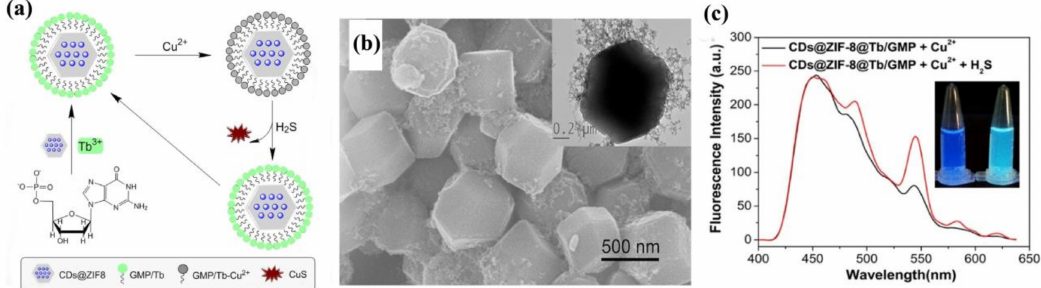
Figure 10. ( a ) Schematic illustration of the preparation of CDs@ZIF-8@GMP/Tb and its working principle for ratiometric detection of H 2 S; ( b ) SEM images of CDs@ZIF-8@GMP/Tb. Inset is